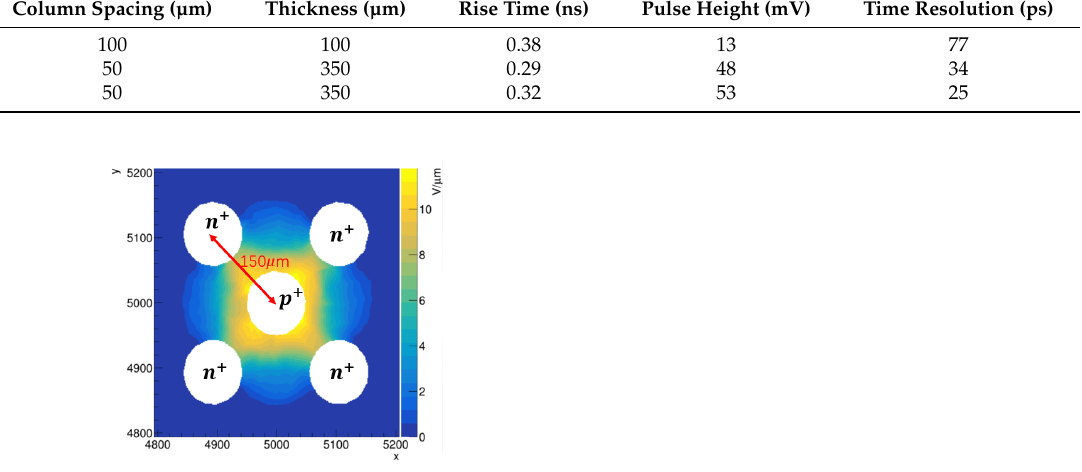
Figure 8. The electric field distribution of x–y cross section for 3D-4H-SiC-5E detector with 500 V bias